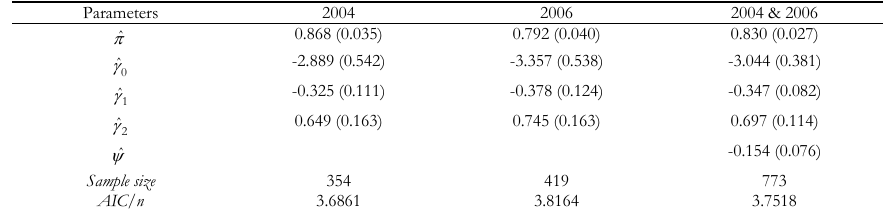
Comparison of CUB models for separate and aggregate surveys